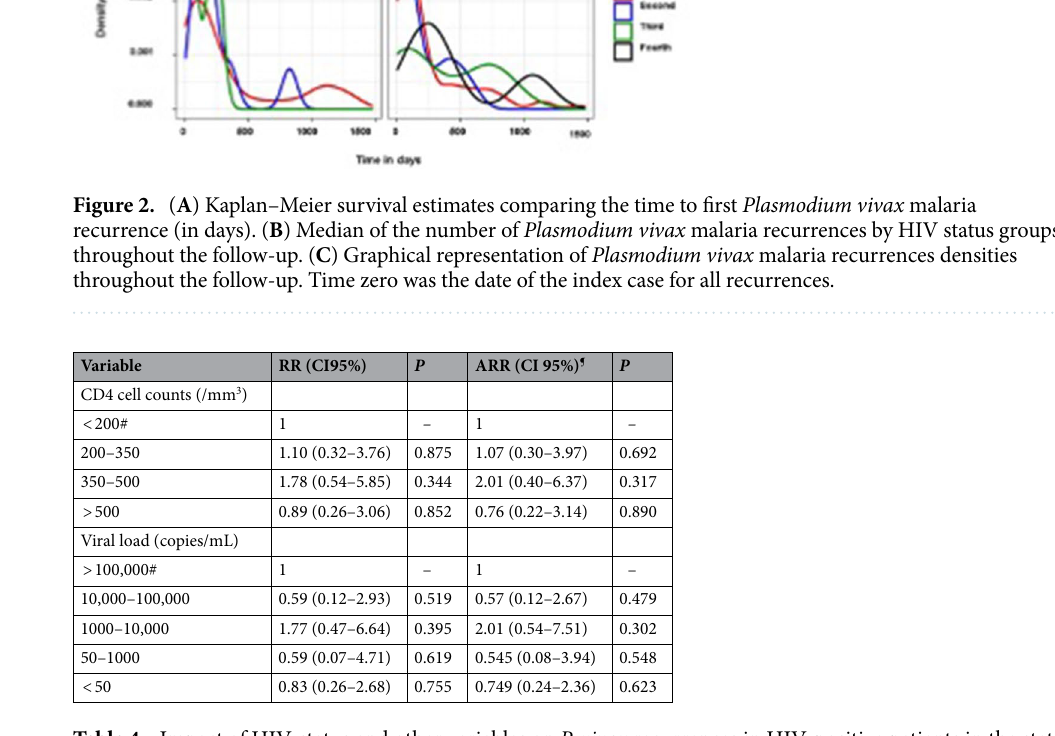
Table 4. Impact of HIV-status and other variables on P. vivax recurrences in HIV-positive patients in the state of Amazonas, Brazil, 2012–2020. # Reference groups. ¶ Adjusted by gender and years of education.